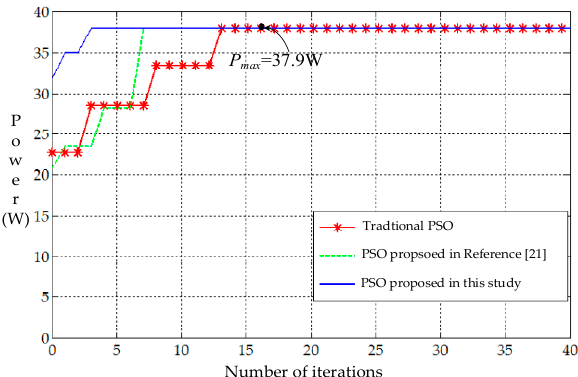
Figure 12. Comparison results of maximum power tracking in Case 3 using the traditional PSO, the improved PSO proposed in Reference [21], and the PSO proposed in this study.